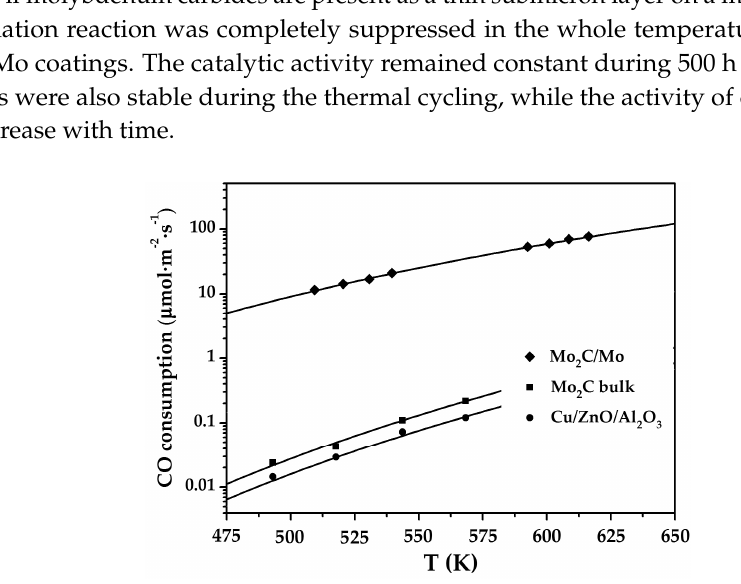
Figure 8. Water–gas shift reaction rate as a function of temperature on different catalysts. Reaction conditions: p CO = 0.003 atm, p H2O = 0.013 atm, p H2 = 0.4 atm, balance-He. Total flow: 50 cm 3 · min − 1 (STP).